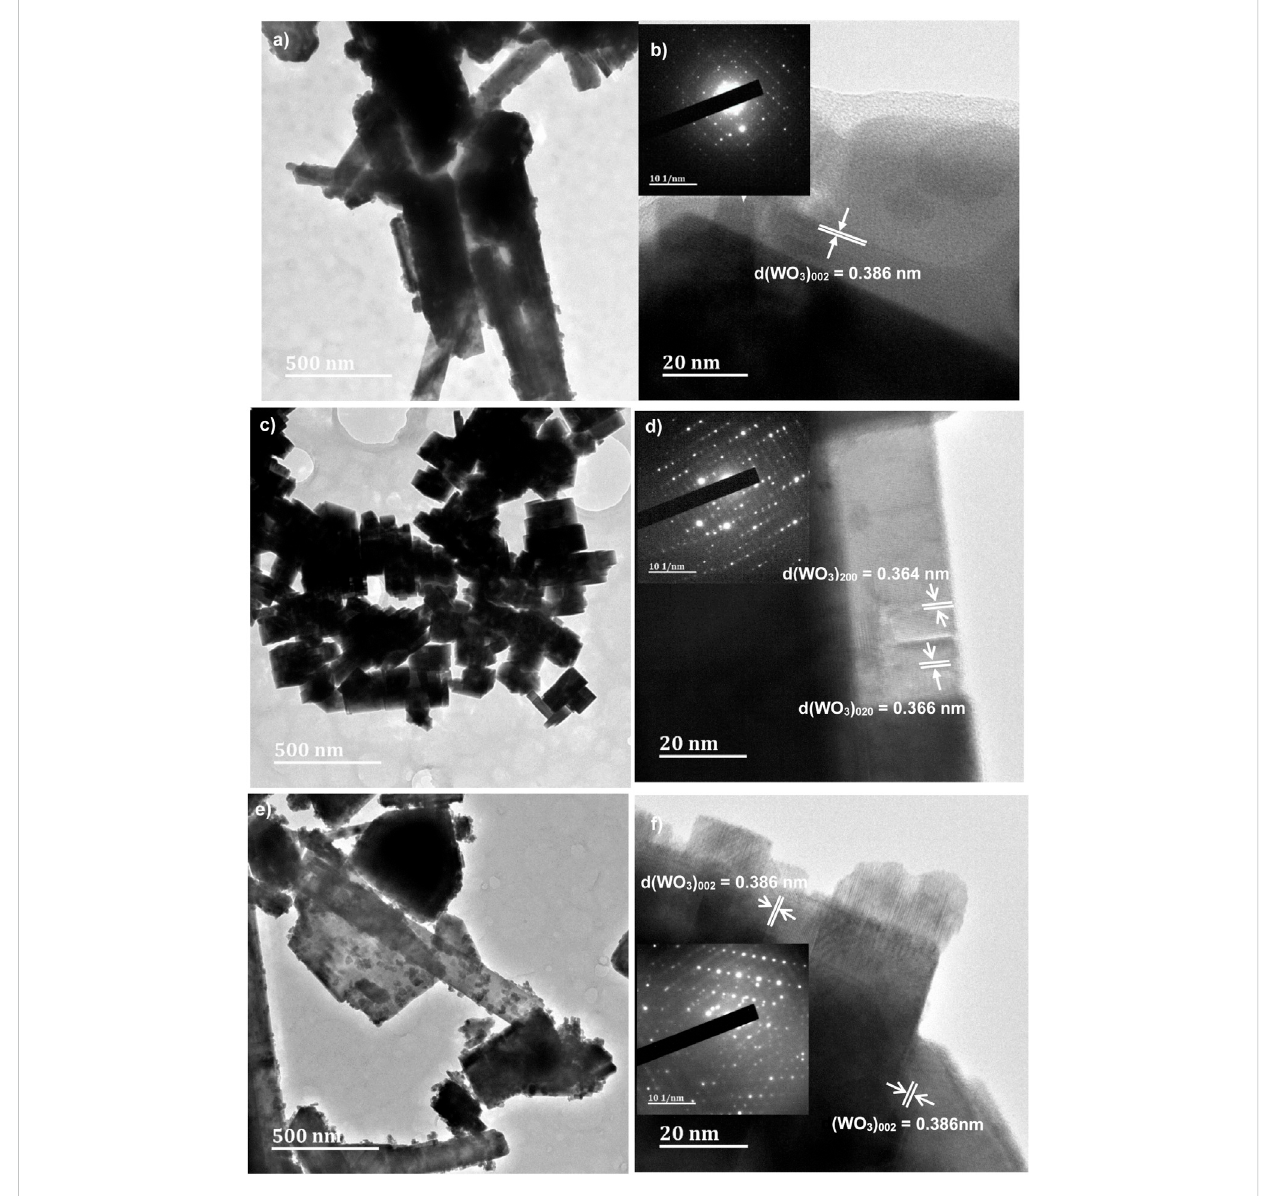
FIGURE 6 High Resolution-Transmission Electron Microscope (HR-TEM) of the acids assisted synthesis of WO 3 samples, and the inset SAED images of (A, B)